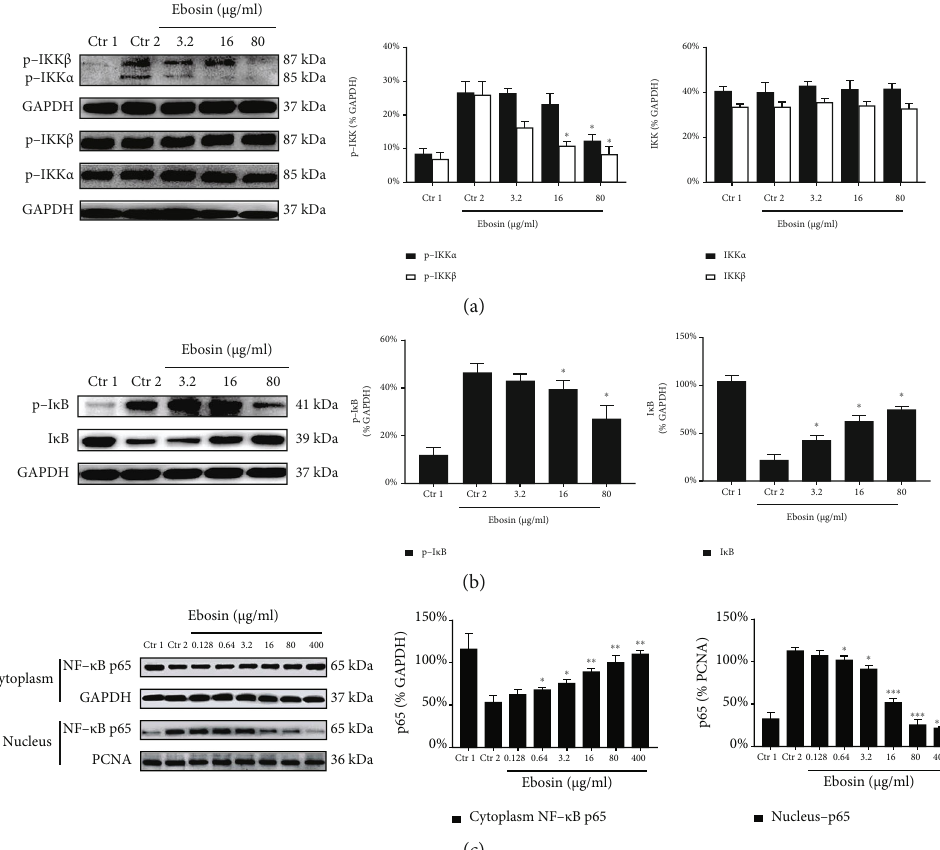
Figure 2: The in fl uences of ebosin on the NF- κ B signaling pathway mediated by TNF- α in FLS. (a) E ff ects of ebosin on the expression of phosphorylated and nonphosphorylated IKK α and IKK β . FLS cells ( 1 × 10 5 /ml ) were incubated in the presence or absence of ebosin for 12h then with TNF- α (10 ng/ml) 3 h. The production of phosphorylated and nonphosphorylated IKK α and IKK β was analyzed with western blot. (b) E ff ects of ebosin on production of phosphorylated I κ Ba and nonphosphorylated I κ Ba. The expression levels of phosphorylated and nonphosphorylated I κ Ba were identi fi ed with the same protocols as before. (c) E ff ect of ebosin on nuclear and cytoplasm NF- κ B of FLS. The production of nuclear and cytoplasm NF- κ B was determined by western blot also. All of the data are expressed as the means ± SD from at least 3 independent experiments. P < 0 : 001 , P < 0 : 01 , and P < 0 : 05 compared to the control 2 (FLS incubated with TNF- α ) individually for NF- κ B, IKK α , IKK β , and I κ Ba.